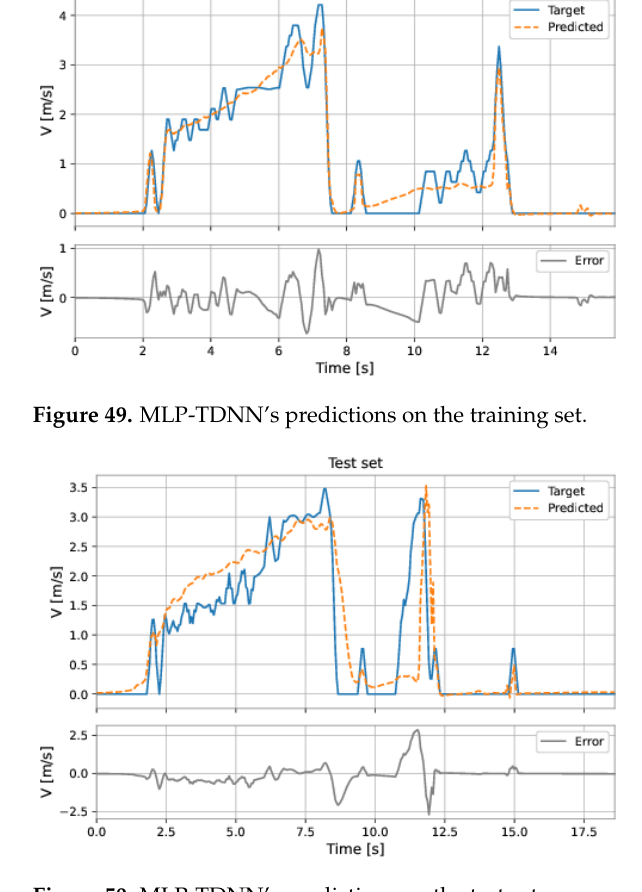
Figure 50. MLP-TDNN’s predictions on the test